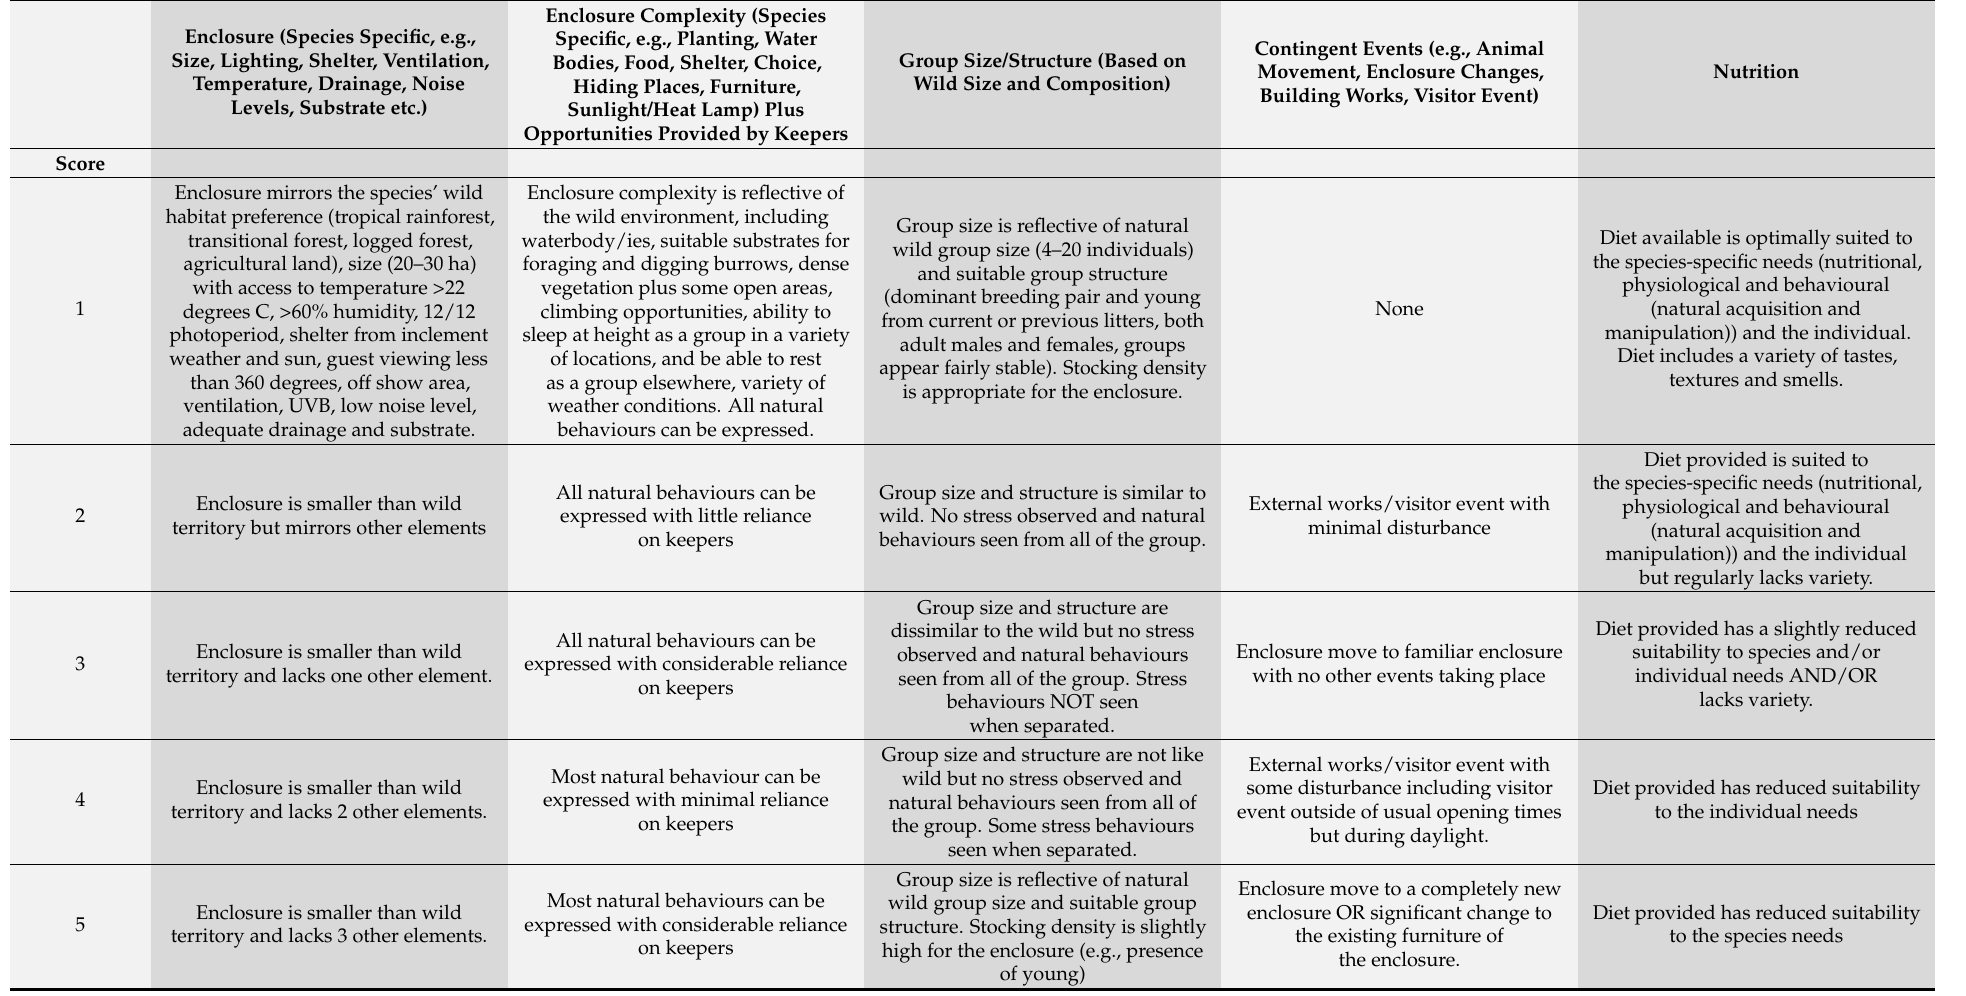
Table 3. Factors scored within the environmental